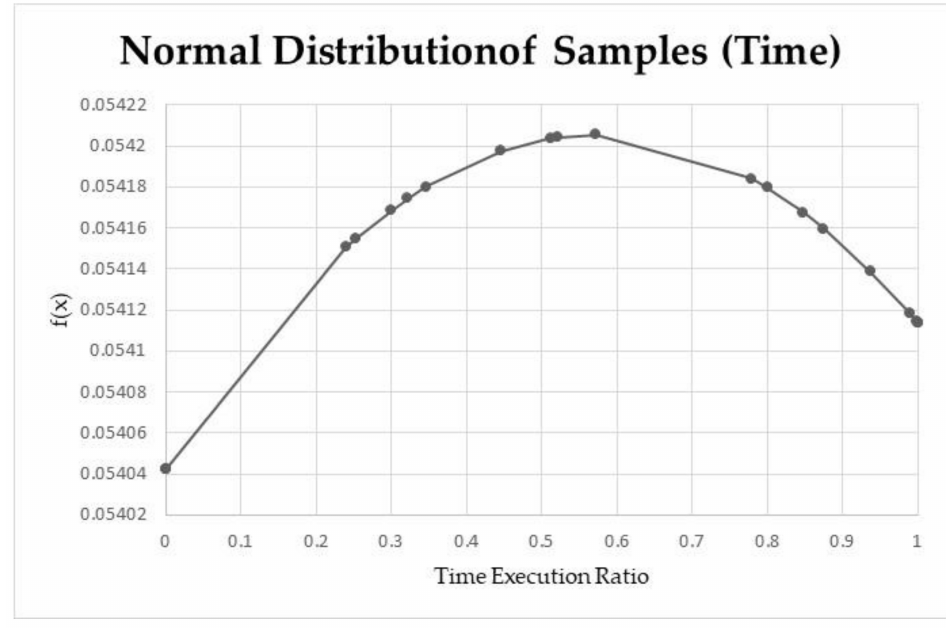
Figure 4. Normal distribution of time (23